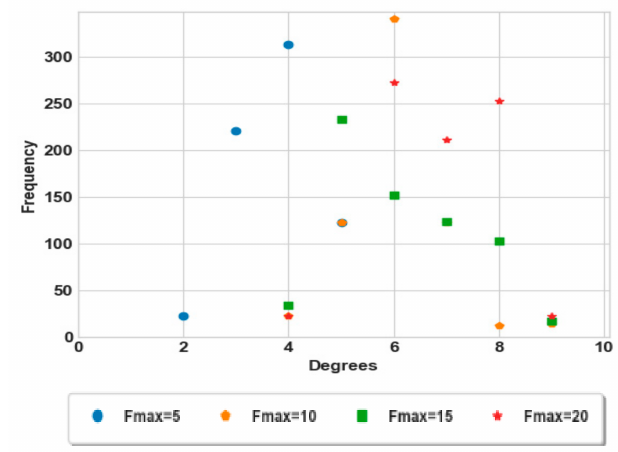
Figure 7. Degree distribution of the social network.